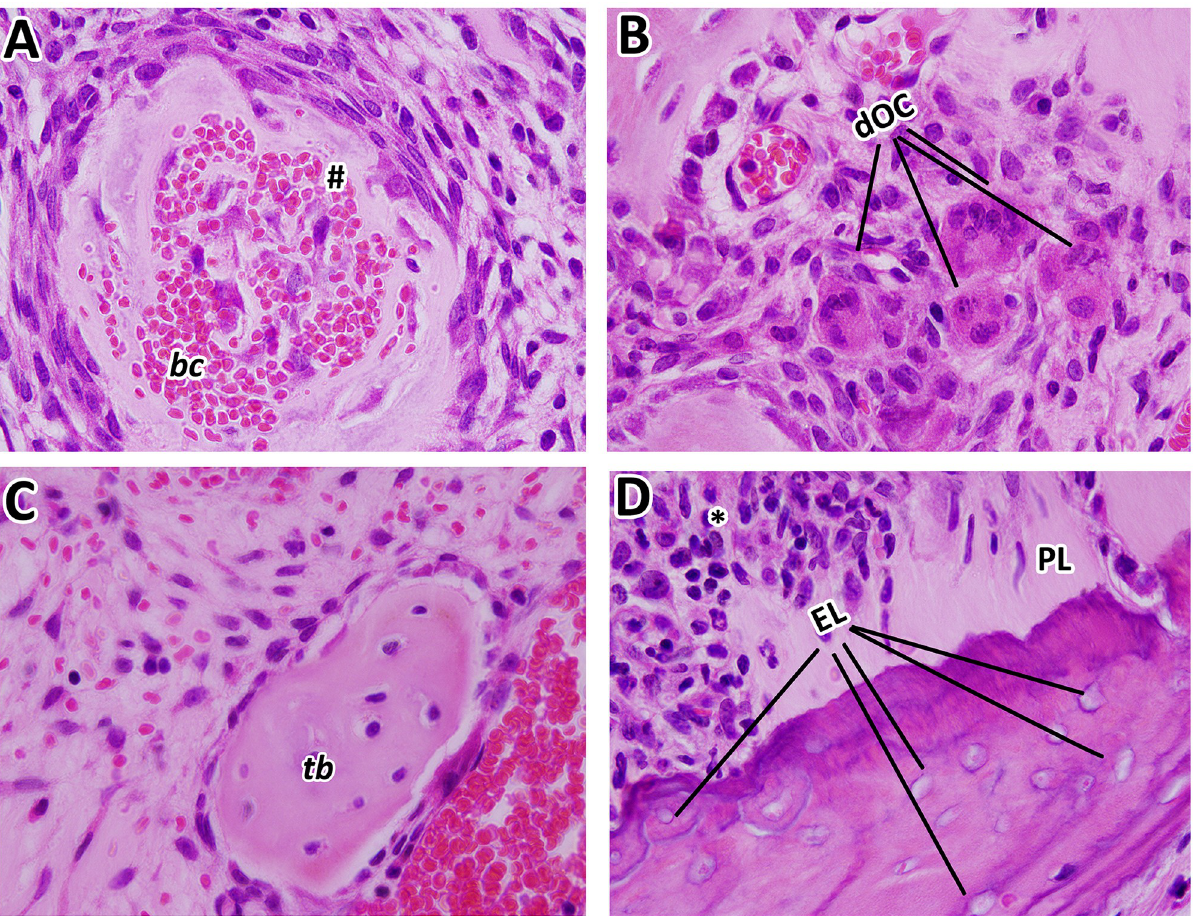
Fig 5. Details of MRONJ lesions in 129Sv senescent female mice treated with ZA at 21 days post tooth extraction. Representative transversal sections are observed throughout 21days, from the central area of alveolar sockets, 100x magnification. A) Nodular formation of mineralized matrix surrounding blood clot, associated with a highly cell contingent; B) detached osteoclast in the connective tissue; C) short newly formed bone trabeculae; D) non-vital alveolar bone presenting empty osteocytes lacunae close to the remaining periodontal ligament. MRONJ are indicated with letters and symbols, as follow: # nodular formation, dOC = detached OC, PL = remaining Periodontal Ligament, EL = Empty Lacunae, � = inflammatory infiltrate.